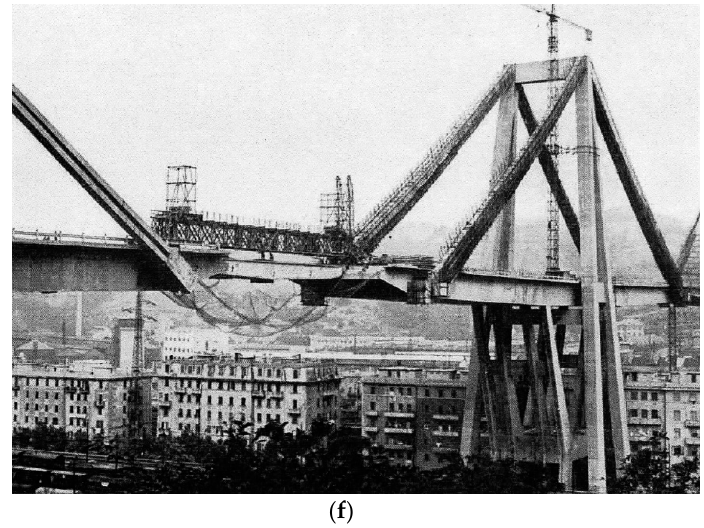
Figure 5. ( a ) Placing the span on the cantilevers of supports Nos. 6 and 7 of the overpass (Morandi, 1968). ( b ) Construction of pylon and cantilevers of support No. 9 of the viaduct (Morandi, 1968). ( c ) Pre-stressing temporary tendons laid on top of the cantilevers during the construction of the cantilevers (Morandi, 1968). ( d ) Viaduct supports at different stages of construction: No. 9—completely executed, No. 10—with the two-sided cantilevers made and No. 11—with the pylon made (Morandi, 1968). ( e ) Viaduct supports at different stages of construction: No. 10—with concreted cables and No. 11—with steel tendons before concreting (Morandi, 1968). ( f ) Placing the span on cantilevers of supports Nos. 10 and 11 of the viaduct (Morandi, 1968).